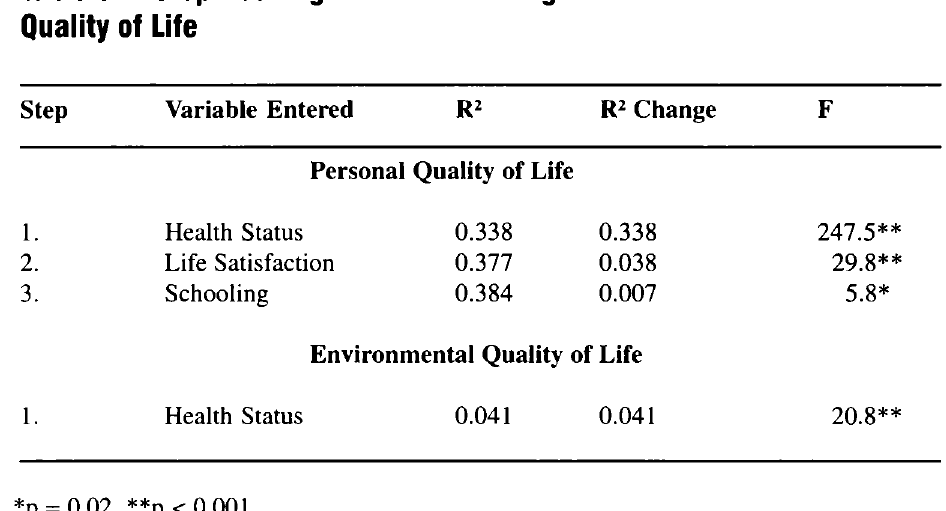
Table 3 : Stepwise Regression Predicting Personal and